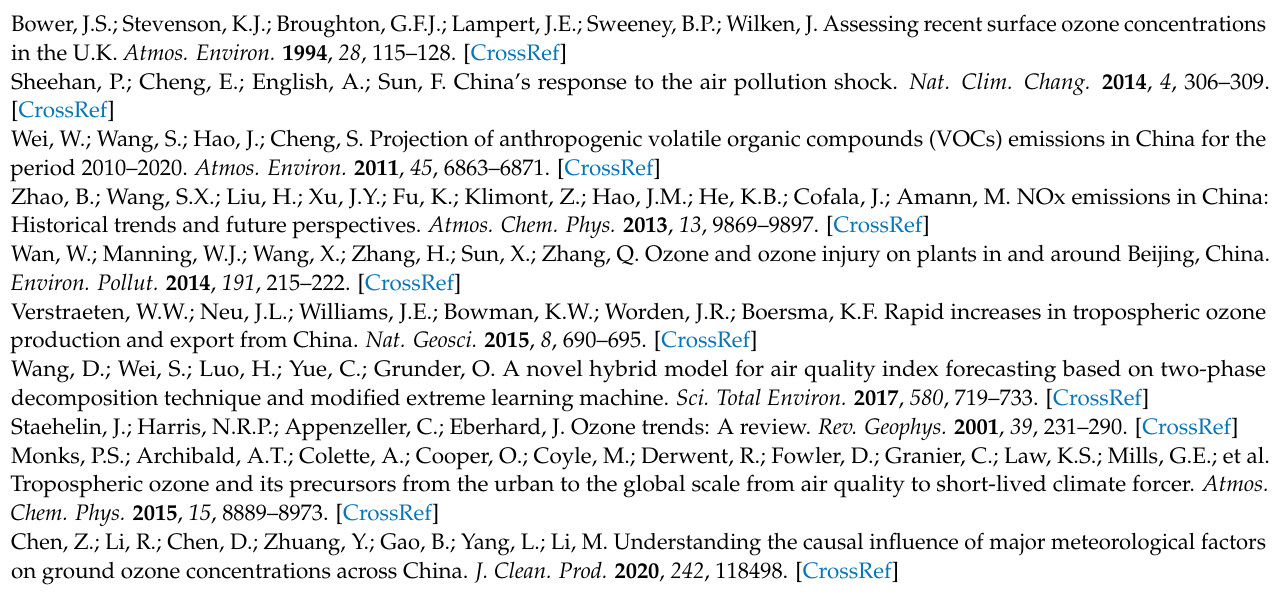
Z-score normalization time series (a) and wavelet power spectrum (b) of relative humidity (RHU), Figure S4: Z-score normalization time series (a) and wavelet power spectrum (b) of solar altitude, Figure S5: Wavelet coherence spectrum (WTC) of 2 m dew temperature and O 3 , Figure S6: Crossed wavelet spectrum (XWT) of 2 m dew temperature and O 3 , Figure S7: Wavelet coherence spectrum (WTC) of 10 m U component of wind (10 m U wind) and O 3 , Figure S8: Crossed wavelet spectrum (XWT) of 10 m U component of wind (10 m U wind) and O 3 , Figure S9: Wavelet coherence spectrum (WTC) of 10 m V component of wind (10 m V wind) and O 3 , Figure S10: Crossed wavelet spectrum (XWT) of 10 m V component of wind (10 m V wind) and O 3 , Figure S11: Wavelet coherence spectrum (WTC) of relative humidity (RHU) and ozone (O 3 ), Figure S12: Crossed wavelet spectrum (XWT) of relative humidity (RHU) and ozone (O 3 ), Figure S13: Wavelet coherence spectrum (WTC) of surface net solar radiation (SNSR) and ozone (O 3 ), Figure S14: Crossed wavelet spectrum (XWT) of surface net solar radiation (SNSR) and ozone (O 3 ), Figure S15: Wavelet coherence spectrum (WTC) of solar altitude and ozone (O 3 ), Figure S16: Crossed wavelet spectrum (XWT) of solar altitude and ozone (O 3 ), Figure S17: Wavelet coherence spectrum (WTC) of surface pressure and ozone (O 3 ), Figure S18: Crossed wavelet spectrum (XWT) of surface pressure and ozone (O 3 ), Table S1: Parameters from ERA5 land reanalysis data and observation stations, Table S2: Number and percentage of missing gaps for air pollutants and meteorological data, Table S3: The periods and phase relationship of influencing factors and